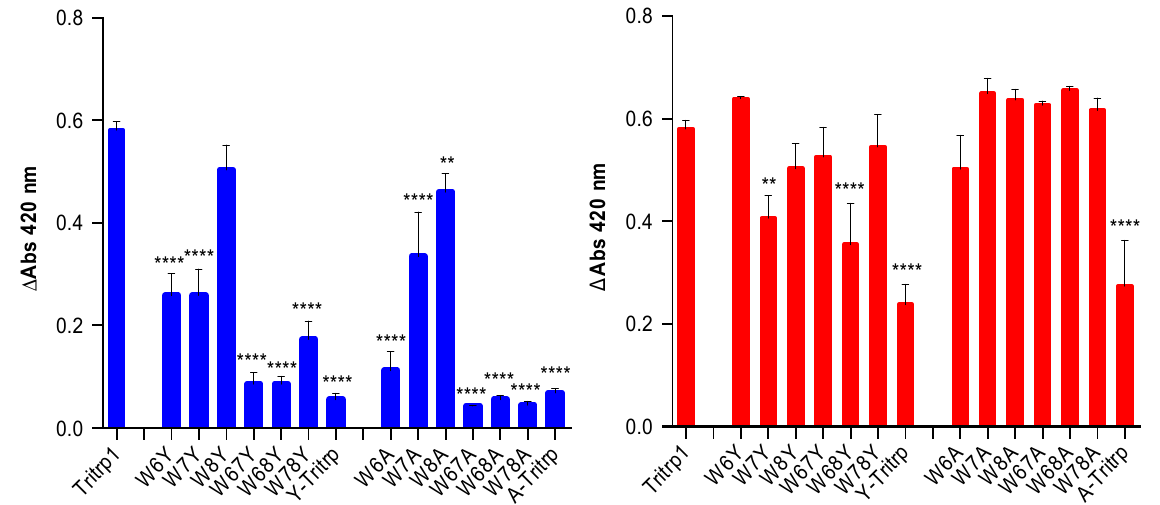
Figure 10. Change in absorbance ( Δ Abs 420 ) after 55 min of incubation of E. coli ML35p in the presence of Tritrp1 and its analogs at 4 µM (blue) and at the respective MICs for each peptide (red). For peptides with a range of MICs, the higher concentration was considered. Results are the mean ± SD ( n =